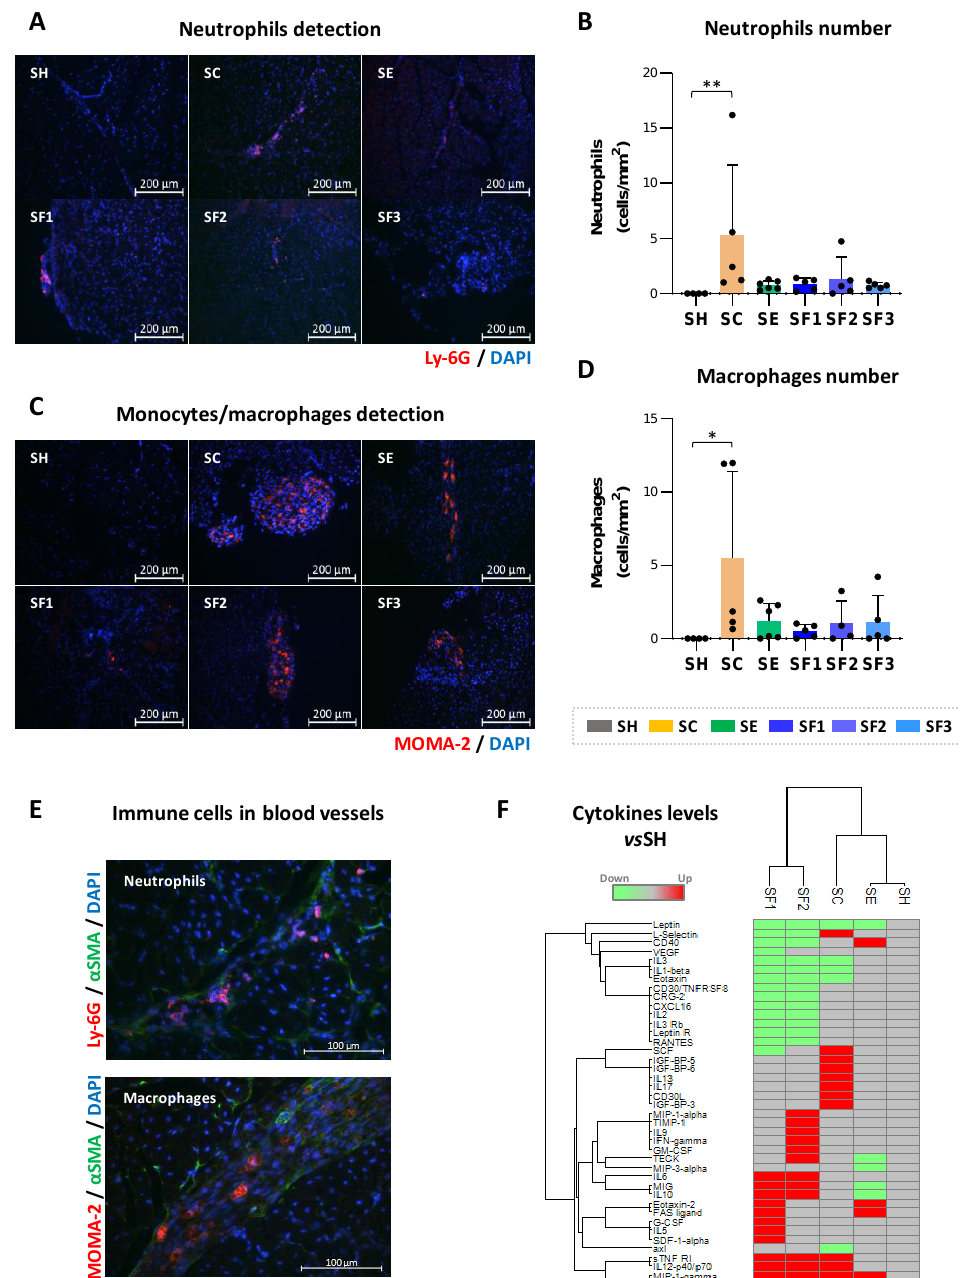
Figure 4. CACs administration modulates the recruitment of neutrophils and macrophages to the ischemic tissues. ( A ) Neutrophils (Ly-6G, red) and ( C ) macrophages (MOMA-2, red) were detected on day 21 by IHC in limb muscles of ischemic mice but not in shams. The number of ( B ) neutrophils and ( D ) macrophages (cells/mm 2 ) was measured in all groups per tissue area and represented as cells/mm 2 . ( E ) Both, neutrophils Ly-6G (red) and macrophages MOMA-2 (red) were highly present in blood vessels, which were identified with anti- α -SMA antibodies (green). ( F ) Hierarchical cluster with differential cytokines levels found vs. SH group. Groups analyzed: Sham, surgery controls (SH, n:4); ischemic mice, un-treated (SC, n:5): ischemic mice with unstimulated CACs (SE, n:6) or pre-stimulated with atherosclerotic factors (SF: n:15: SF1, n:5; SF2, n:5; SF3, n:5). Data were presented as mean ± SD. Significant differences were seen by Kruskal-Wallis and Dunn’s multiple comparisons test (* p -value < 0.05, ** p -value < 0.01).